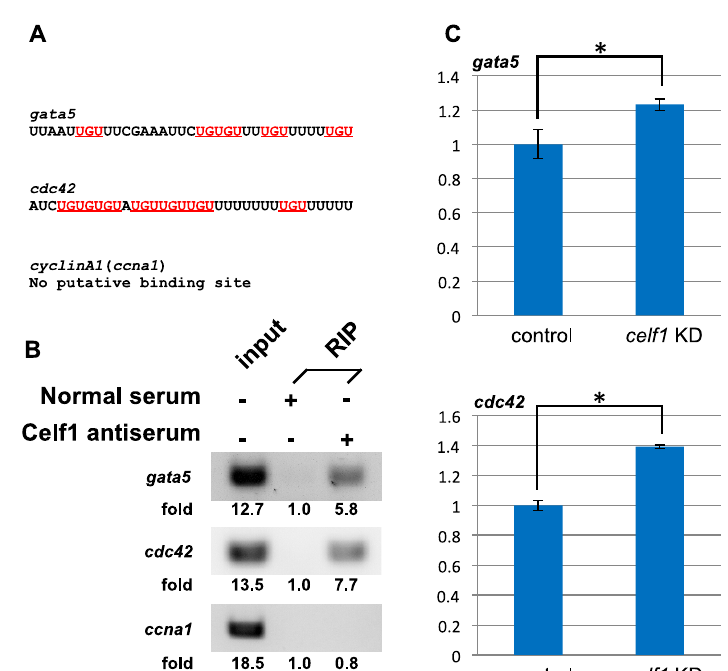
Figure 5. Celf1 binds to several mRNAs which encodes regulators of cell growth and migration in zebrafish embryos. ( A ) Putative Celf1 binding sequences within 3' UTR of candidate mRNAs. Underlines mark UGU repeats. ( B ) Binding of Celf1 with specific